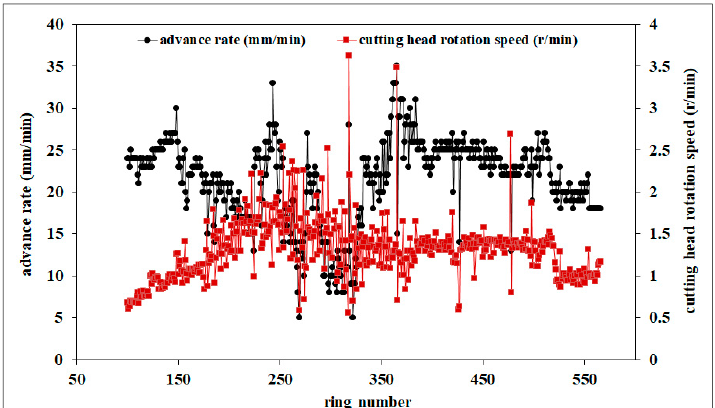
Figure 5. Changes of advance rate and cutting head rotation speed of the machine at the Beijing south-to-north water diversion auxiliary project.